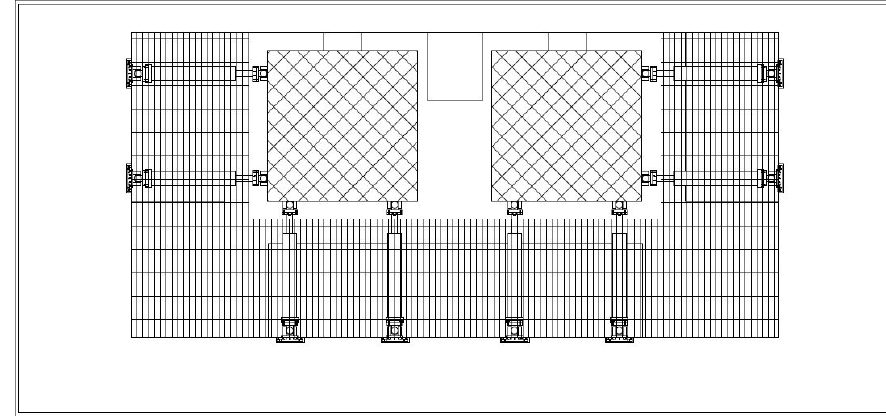
Figure 16. Plan view of the shaking tables system (From [62]).